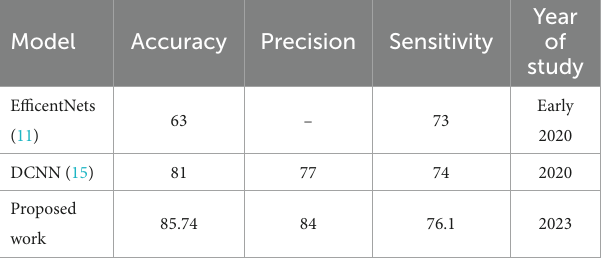
Algorithm 1. Moreover, Table 4 shows a practical application of Algorithm 1 on a sample from the test set with and without classification results agreement.